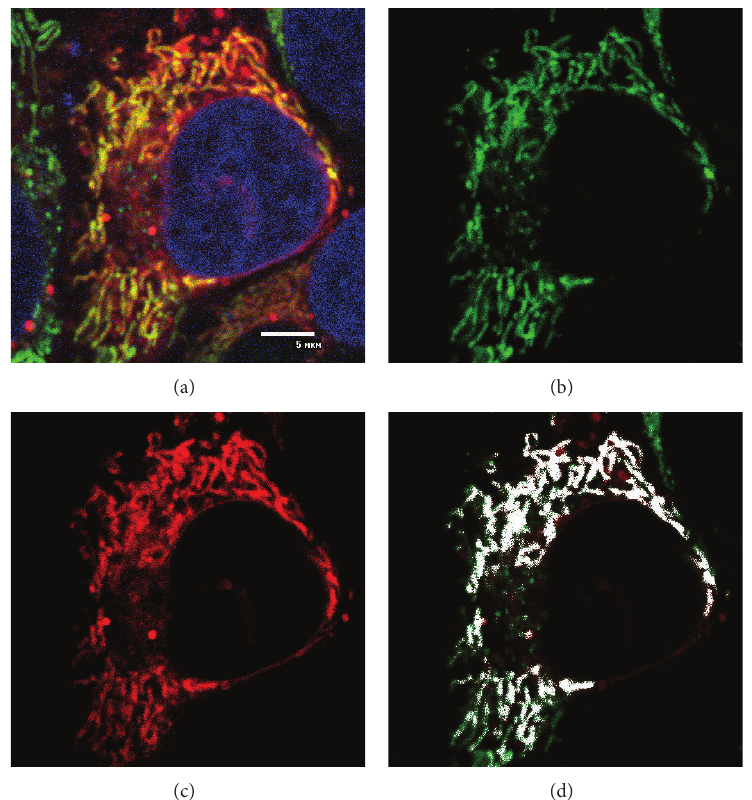
Figure 3: Microphotographs of the A431 cells stained by PFD (novel dye called Rho813 after photoactivation) and the standard dyes MitoTracker Green FM and Hoechst 33342. (a) Image obtained with 3 channels (for each dye) simultaneously. (b) The cell image obtained only with green channel (MitoTracker Green FM). (c) The cell image obtained only with red channel (Rho813). (d) The cell image obtained with overlapping green and red channels that gave white spots (“colocalization” areas of red and green